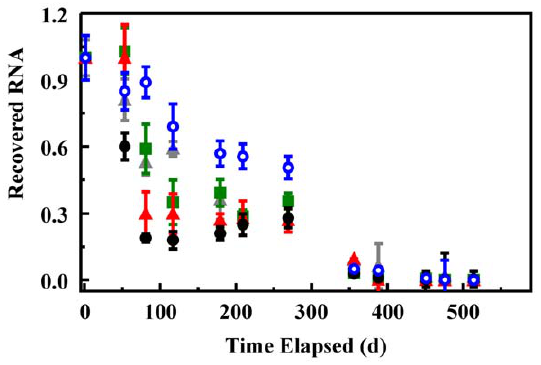
Figure 5. Recovery of RNA adsorbed onto sorbents following storage at 4 6 C. Data is presented as the ratio of the RNA recovered on a given day to that recovered for the same sorbent on day one of the experiment. Recovery of RNA from NS (black), NS-G (blue) NS-T (green), and NS-B (red) sorbents. An RNA control in water under identical storage conditions was also monitored over this time period